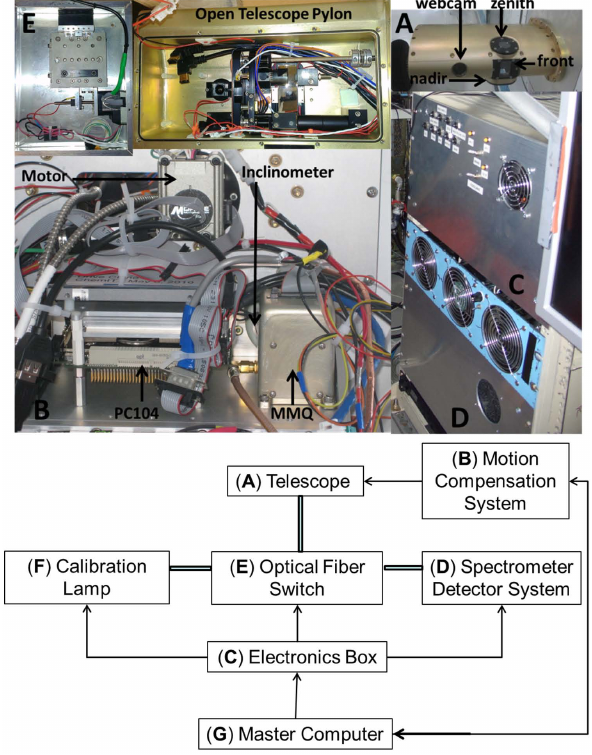
Fig. 2. CU AMAX-DOAS instrument setup aboard the NOAA Twin Otter during the CalNex and CARES